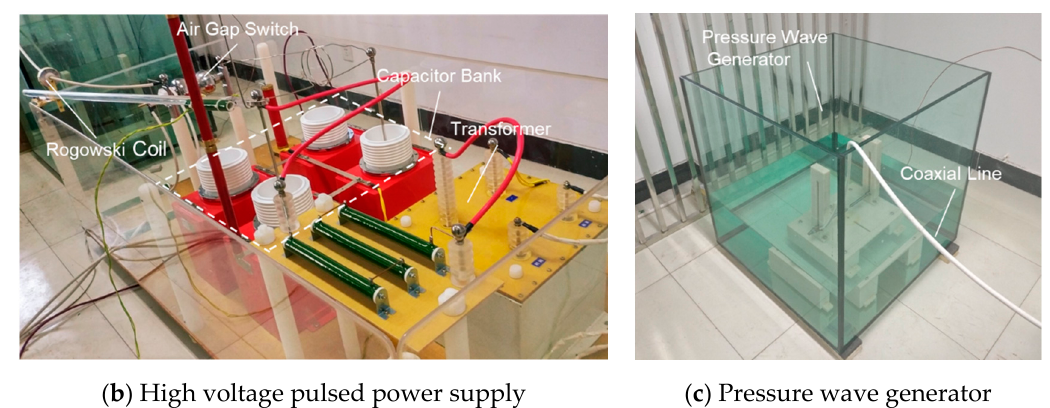
Figure 3. High voltage spark discharge equipment.